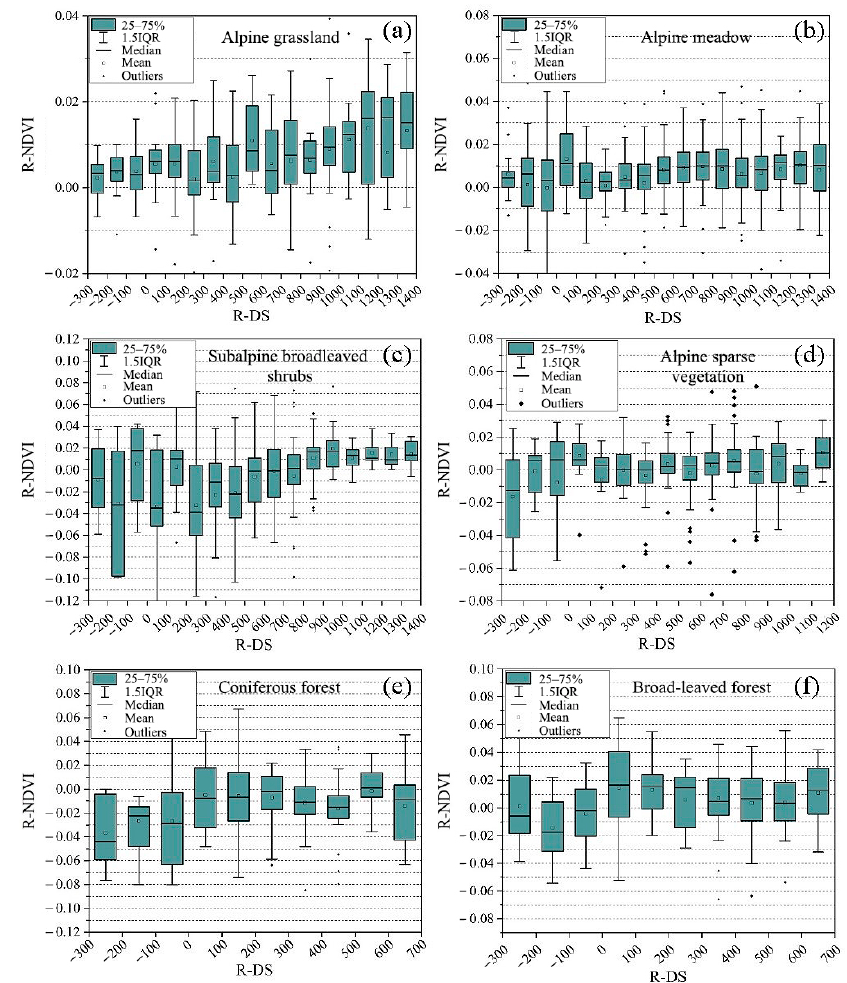
Figure 9. The relationships between R-DS and R-NDVI for di ff erent vegetation types: ( a ) Alpine grassland, ( b ) Alpine meadow, ( c ) Subalpine broadleaved shrubs, ( d ) Alpine sparse vegetation, ( e ) Coniferous forest, ( f ) Broad-leaved